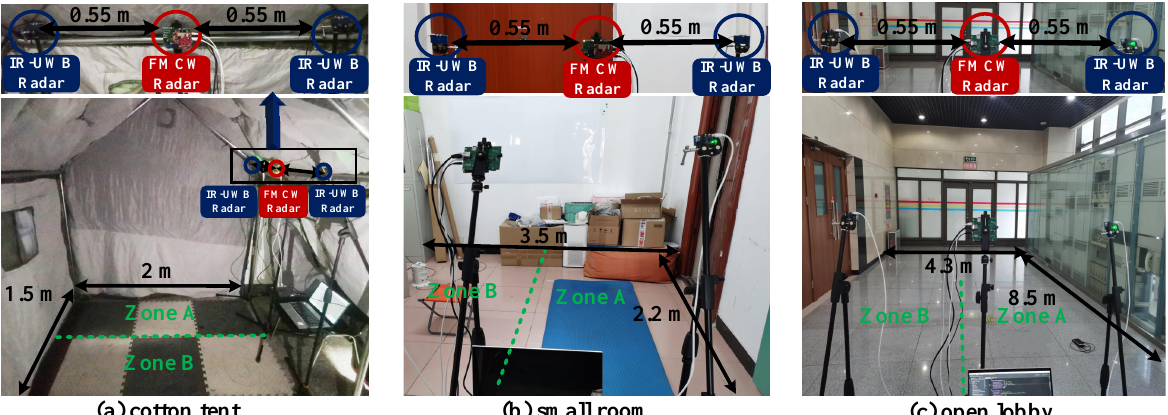
Figure 2. Experimental